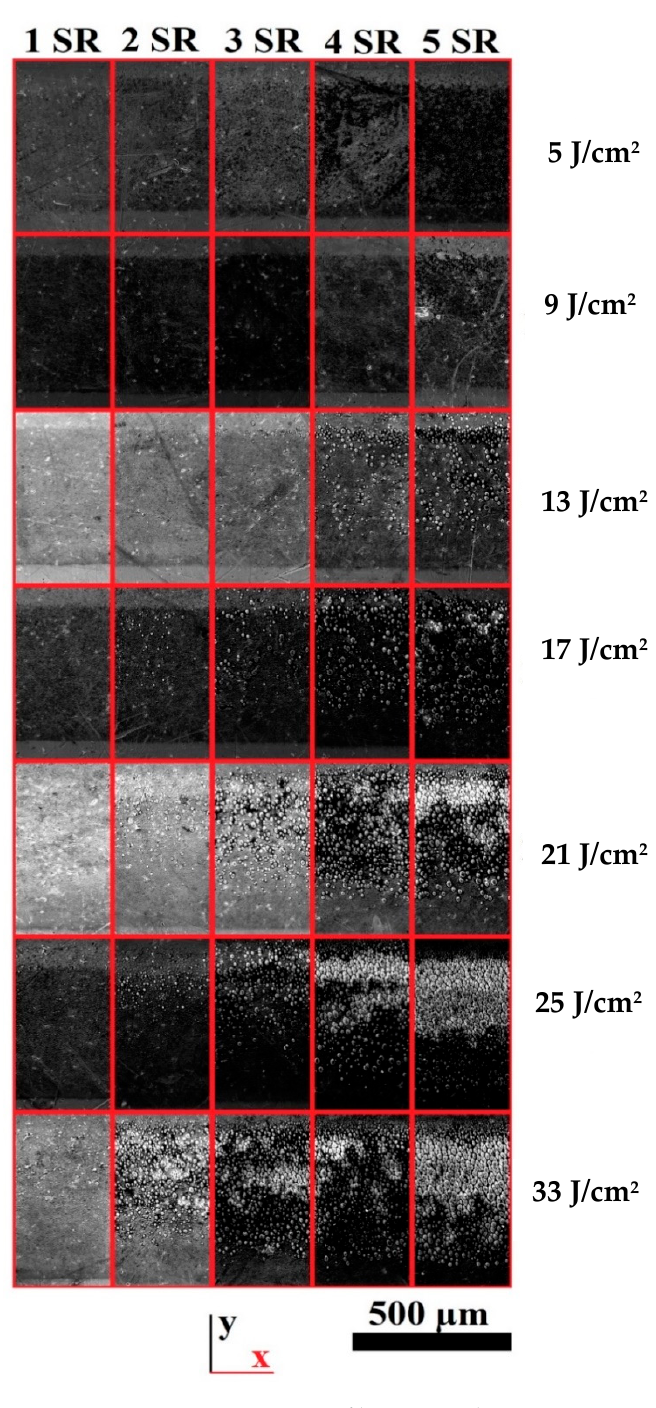
Figure 5. Appearance of laser-treated areas.